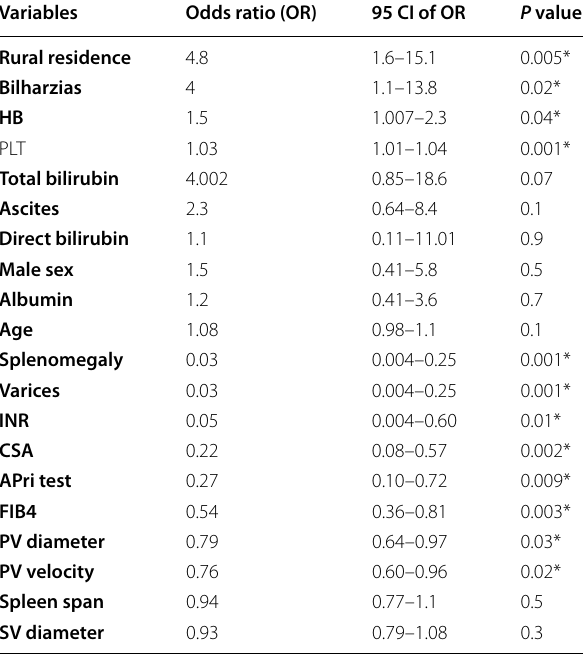
Table 5 Logistic regression analysis of factors predicting the